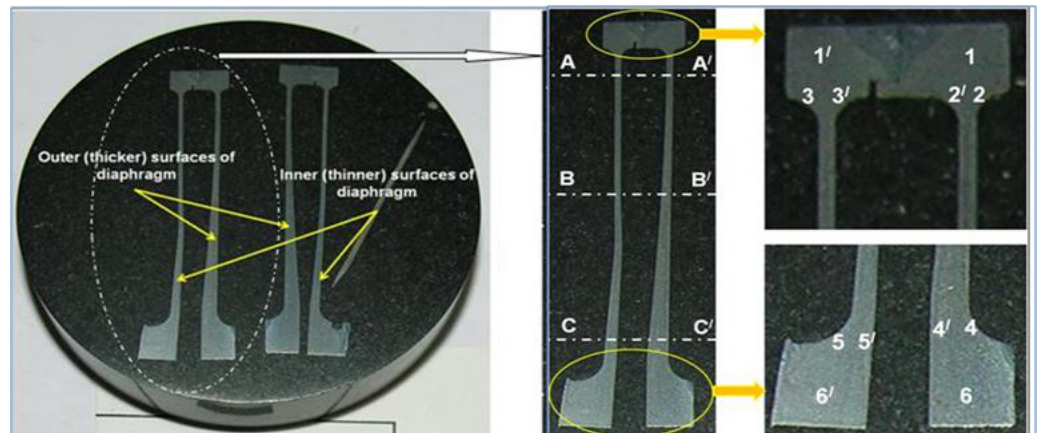
Fig. 9: Cross-sectional profile of inner and outer diaphragms of engine and AMAGB ends (marked points are for microstructure and hardness evaluation).